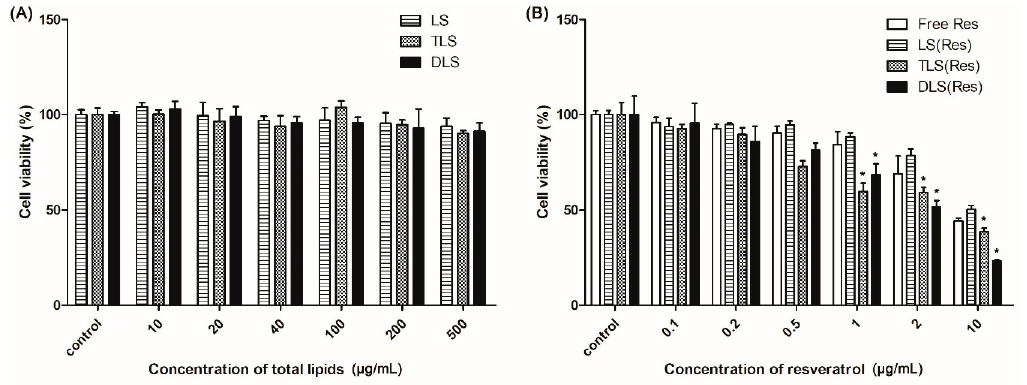
Figure 6. In vitro viability of B16F10 cells after applying the liposomes ( A ) non-carrying resveratrol and ( B ) carrying resveratrol at 24 h. Mean ± S.E.M, n = 4. * indicates a statistical difference from the LS (Res), p < 0.05.